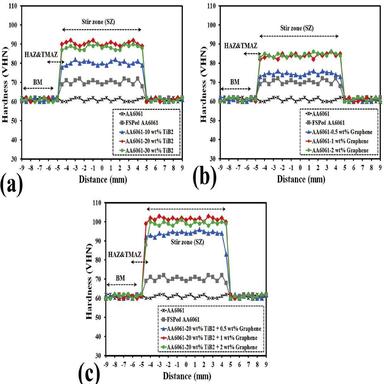
Indentation Vickers micro-hardness profiles across the (a) AA6061-TiB2 single composites, (b) AA6061-Graphene single nanocomposites, and (c) AA6061- Graphene-TiB2 hybrid nanocomposites in contrast to the annealed and FSP modified AA6061 aluminum alloys.